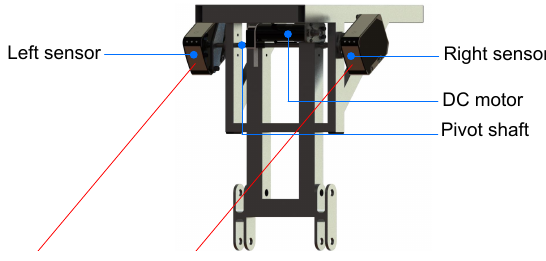
Figure 5. Scanning system positioned on the SCMS frame.